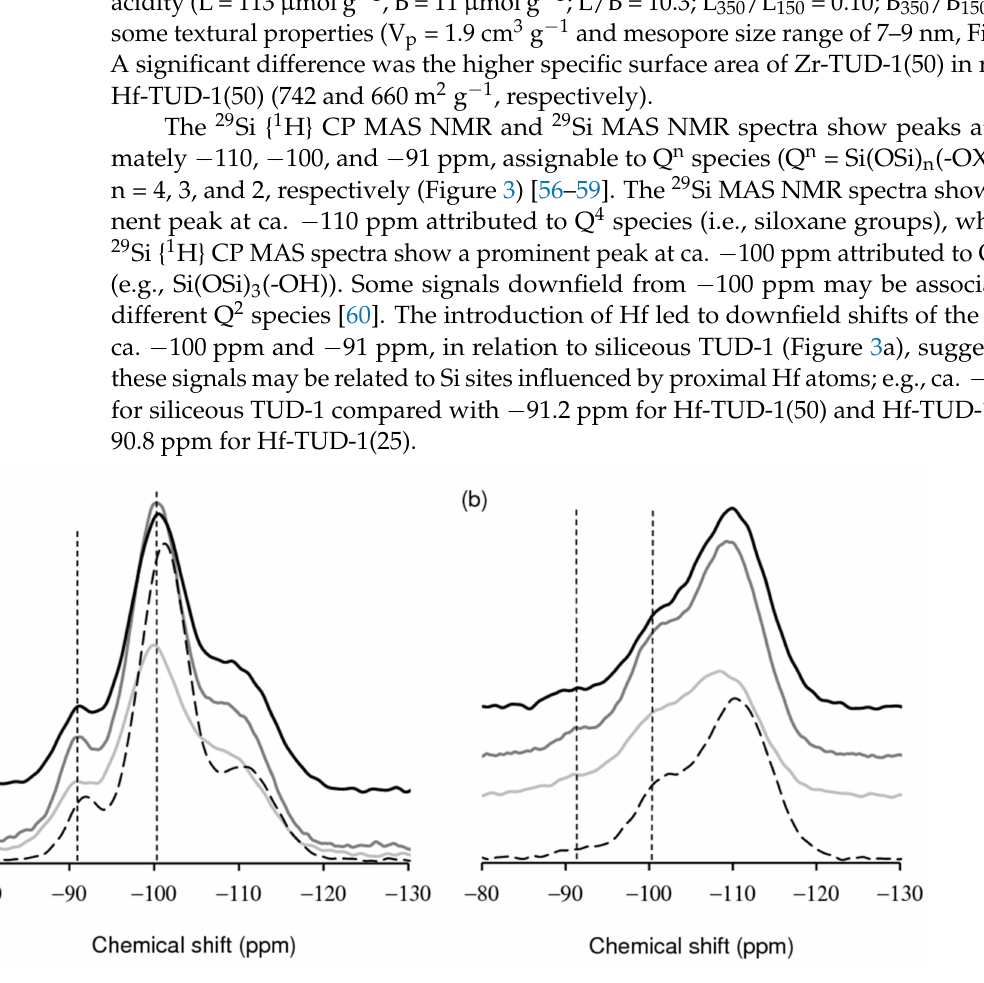
Figure 3. 29 Si{ 1 H} CP MAS ( a ) and 29 Si MAS NMR ( b ) spectra of Hf-TUD-1(75) (black line), Hf-TUD-1(50) (dark grey line), Hf-TUD-25 (light grey line), and TUD-1 (dashed black